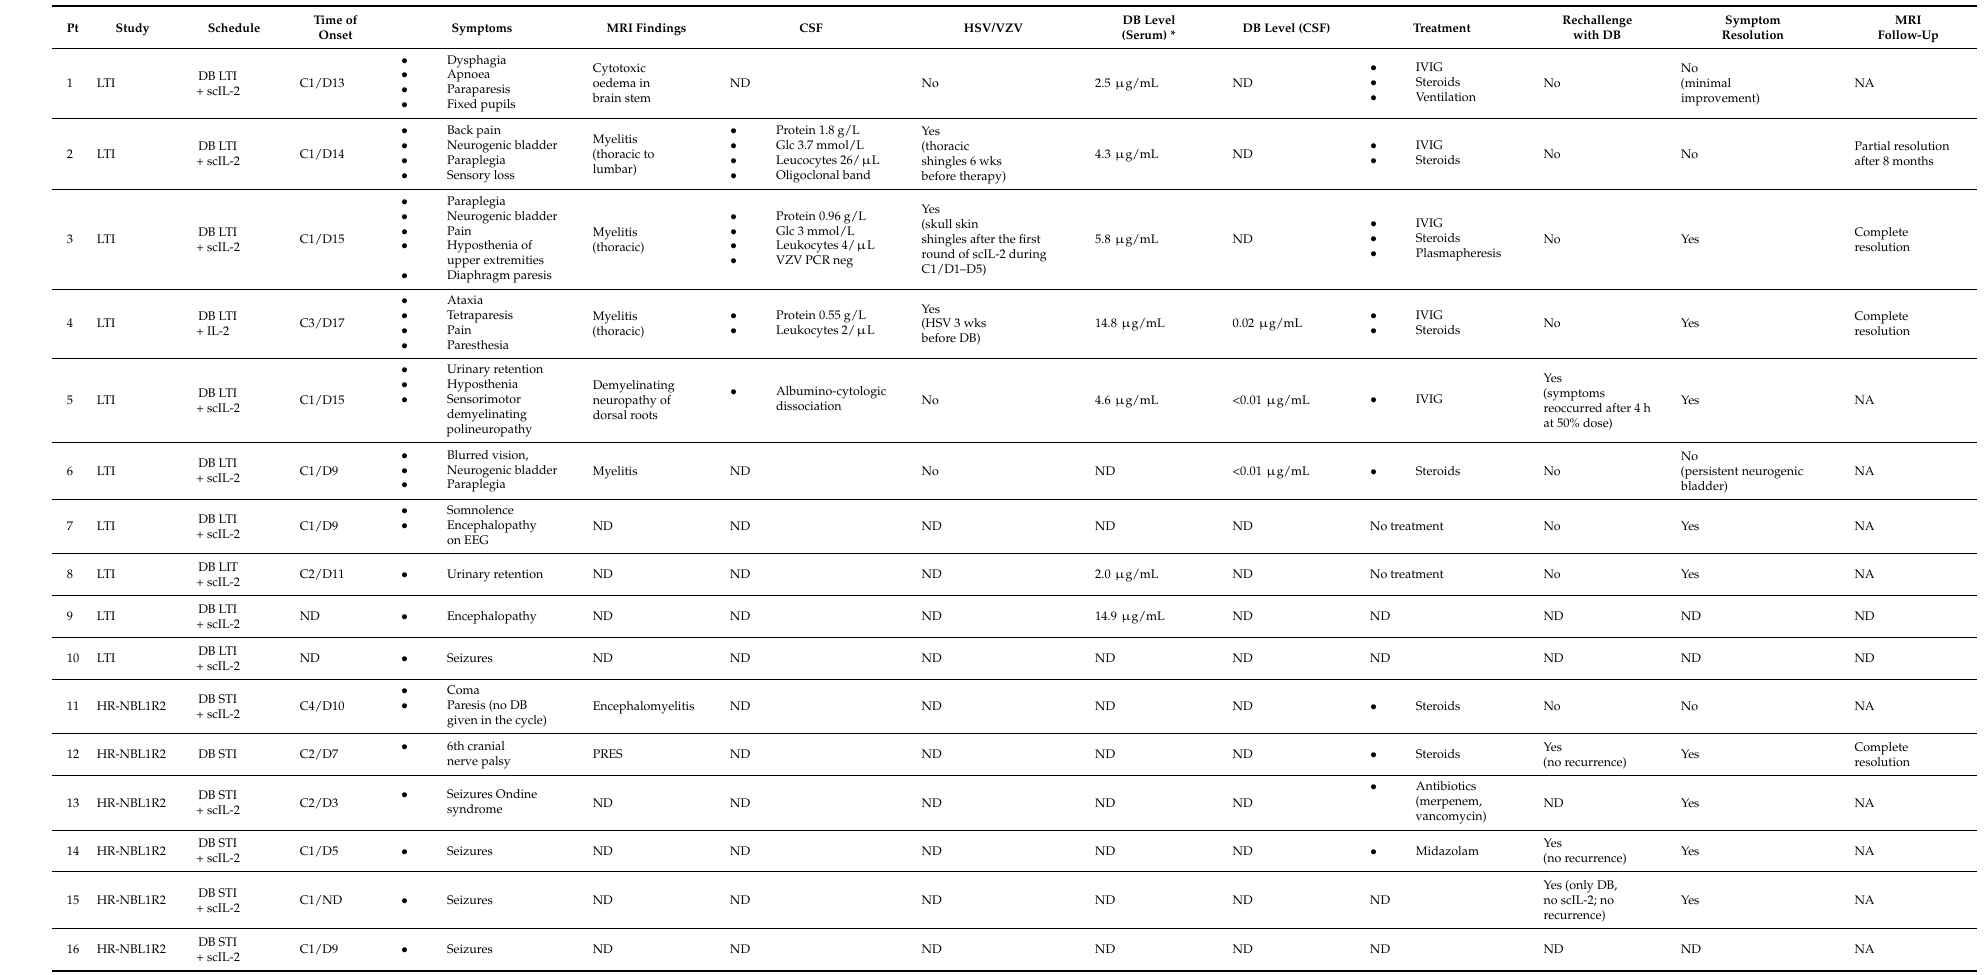
Table 3. Clinical characteristics and management of severe CNS neurotoxicity in the LTI study and the HR-NBL1